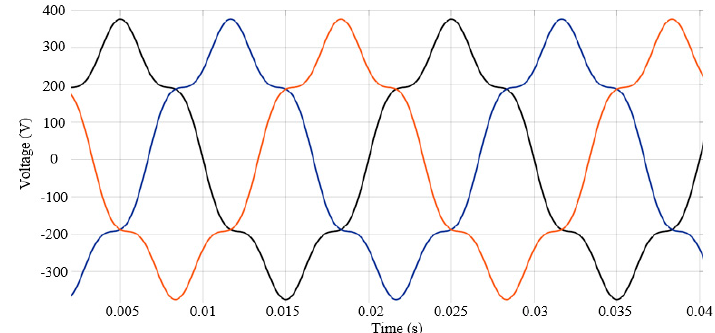
Figure 2. Supply voltages, with 15% of the 5 th -order harmonic superimposed on the fundamental.